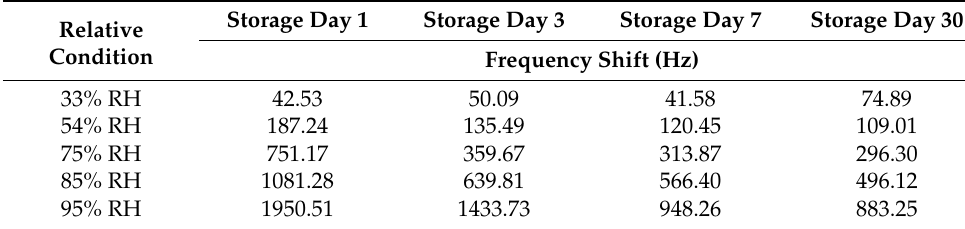
Table 3. The long-term stability test values of 2-PDA-QCM.